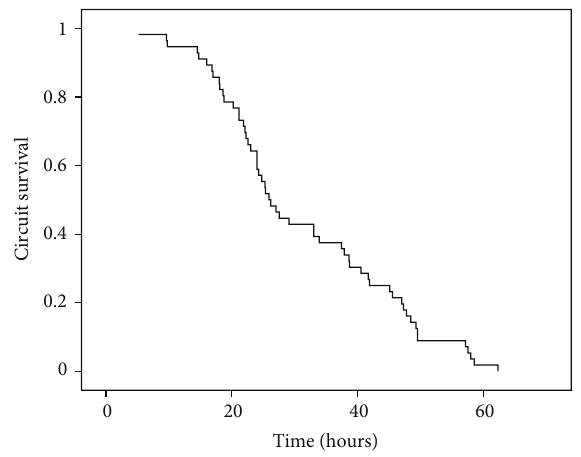
Figure 4: pH changes over time during citrate CRRT. Standard box plot in which the horizontal line represents the median, the thick line represents the interquartile range, and the thin line represents the maximum and minimum values. The circular dots represent the outliers.